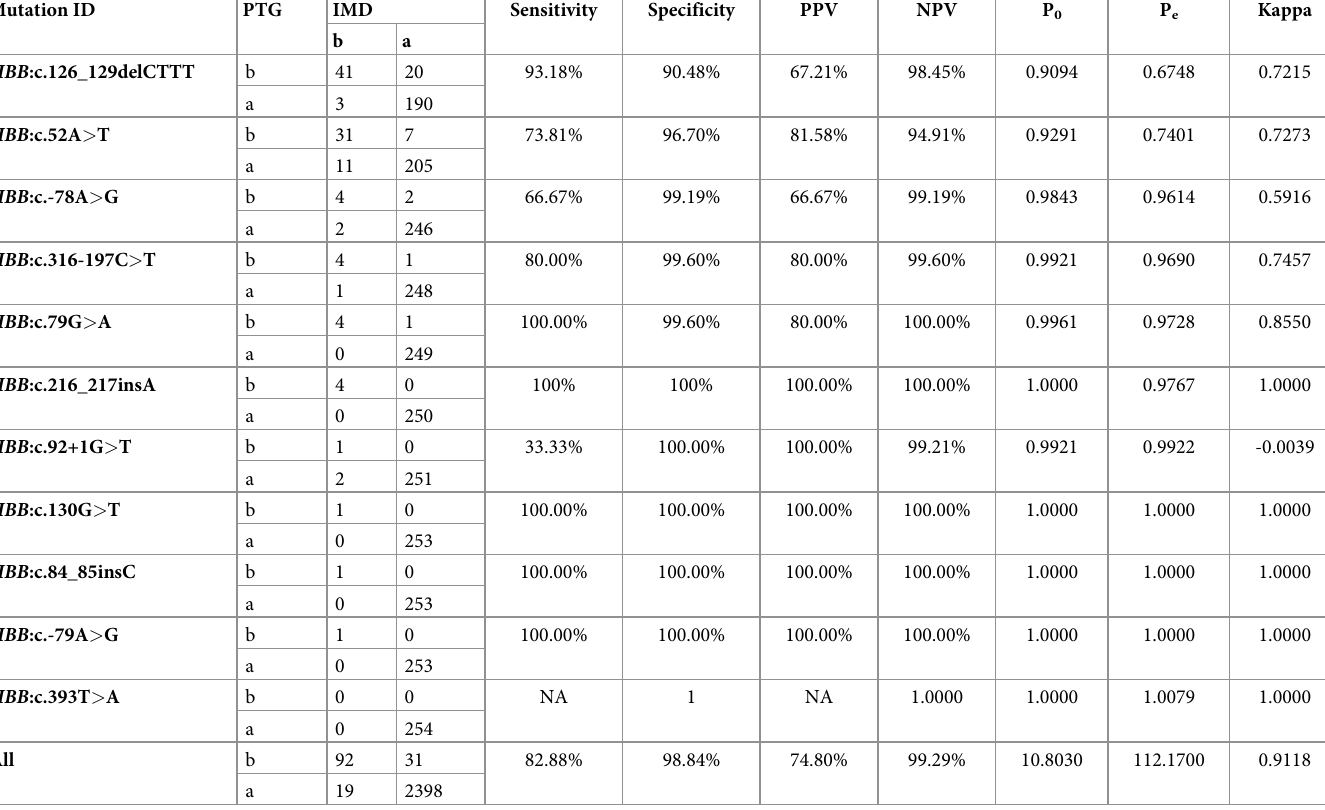
Table 5. The concordance of pseudo-tetraploid genotyping (PTG) with the invasive molecular diagnosis (IMD) (the current gold standard) on the β -thalassemia individual